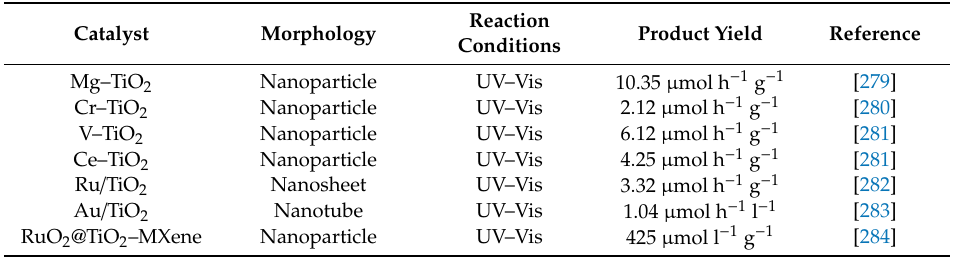
Table 4. Summary of common methods to improve the photocatalytic nitrogen fixation activity of TiO 2 .